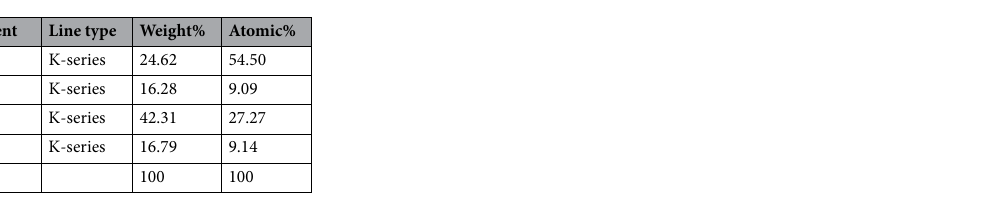
Table 1. Elemental composition of the final nanocomposite CuO/Mn 3 O 4 /ZnO from EDAX spectrum.